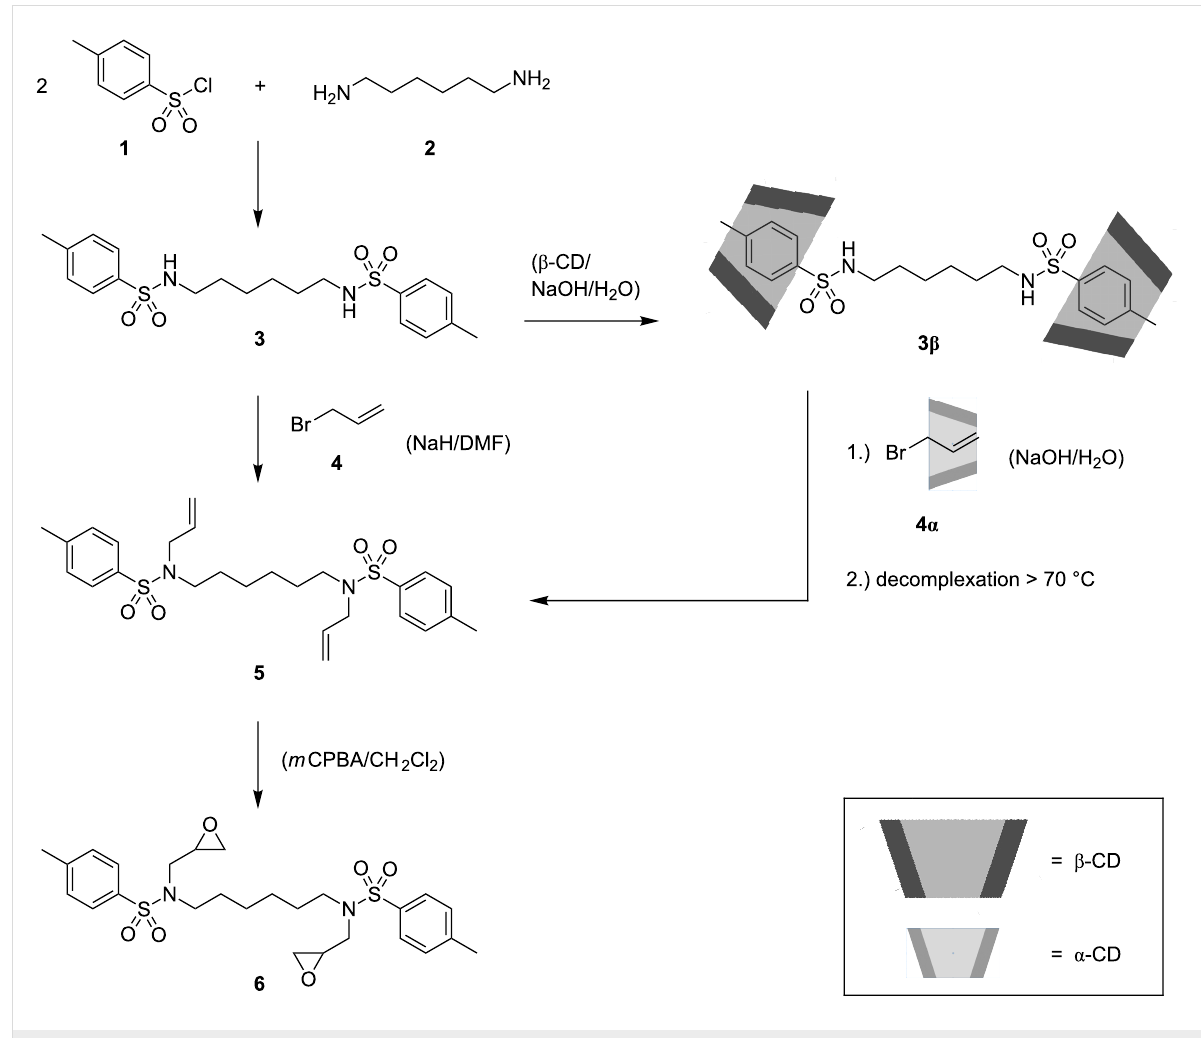
Scheme 1: Synthesis of sulfonamide 3 , N -alkylation of 3 in organic solution and of CD-complex ( 3 β ) in aqueous phase to obtain 5 and the subse- quent epoxidation with m -chloroperbenzoic acid ( m CPBA) to yield product 6